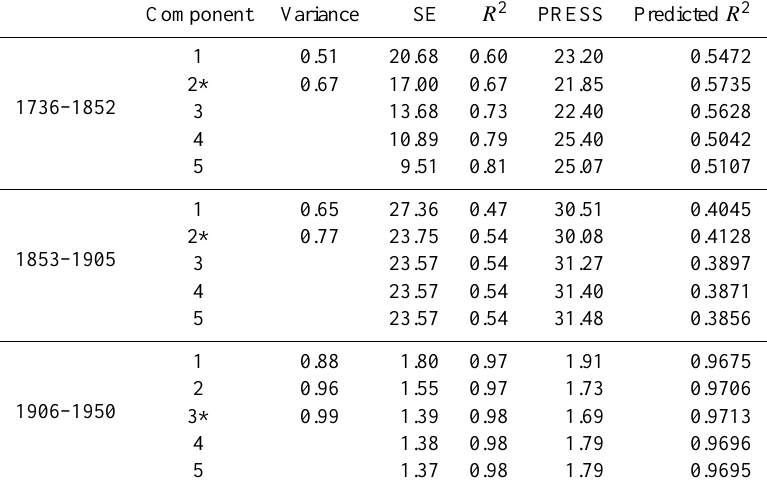
Table 3. The selected PLS regression models for the winter temperatures between regions and individual stations and verifications for 1736–1852, 1853–1905 and 1906–1950 based on the leave-one-out cross-validation method. Component